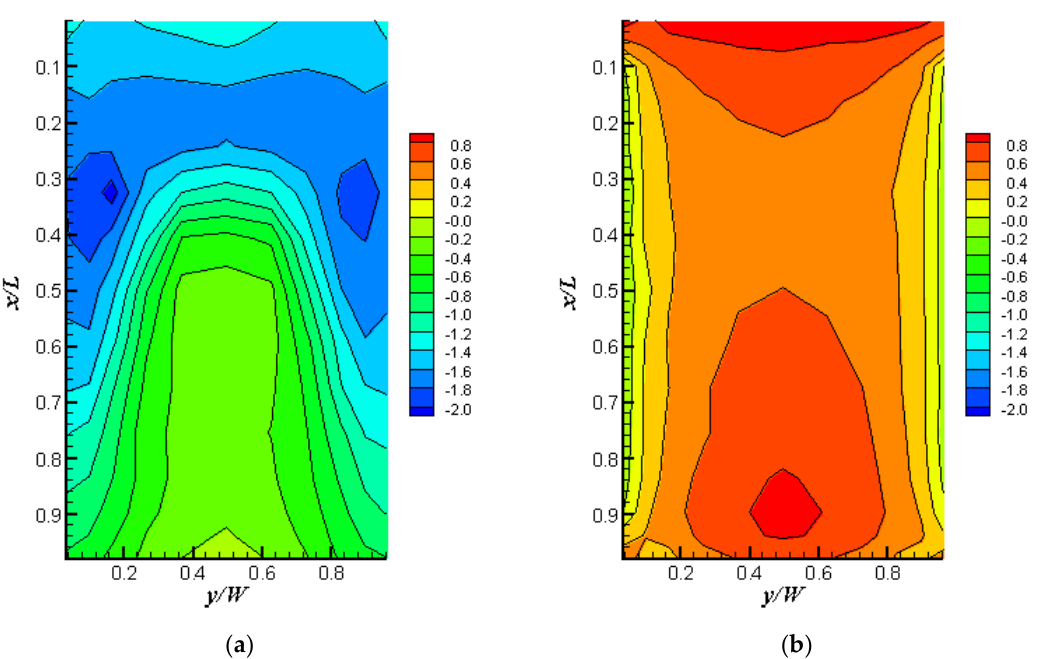
Figure 11. Pressure coe ffi cient contours for α = 30 ◦ and β = 0 ◦ for ( a ) the upper surface and ( b ) the lower surface.